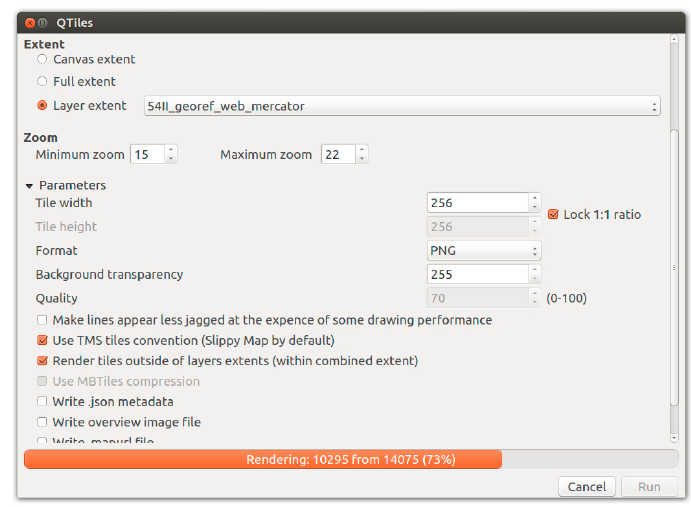
Figure 1. Graphical user interface of the QTiles plugin showing some relevant parameters.